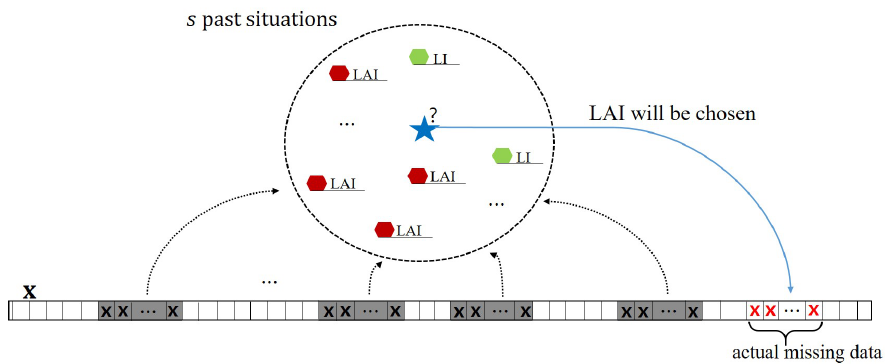
Figure 3. The procedure of extended LAI method (eLAI). The shaded areas represent selected past